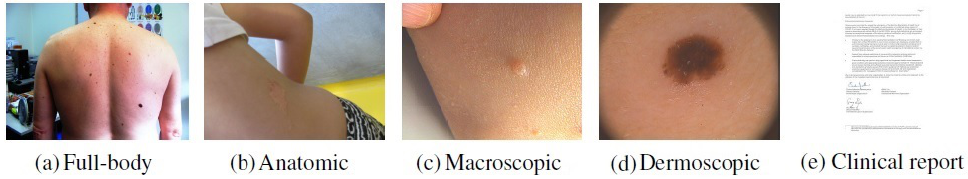
Figure 1. Examples of images belonging to each dermatological modality.